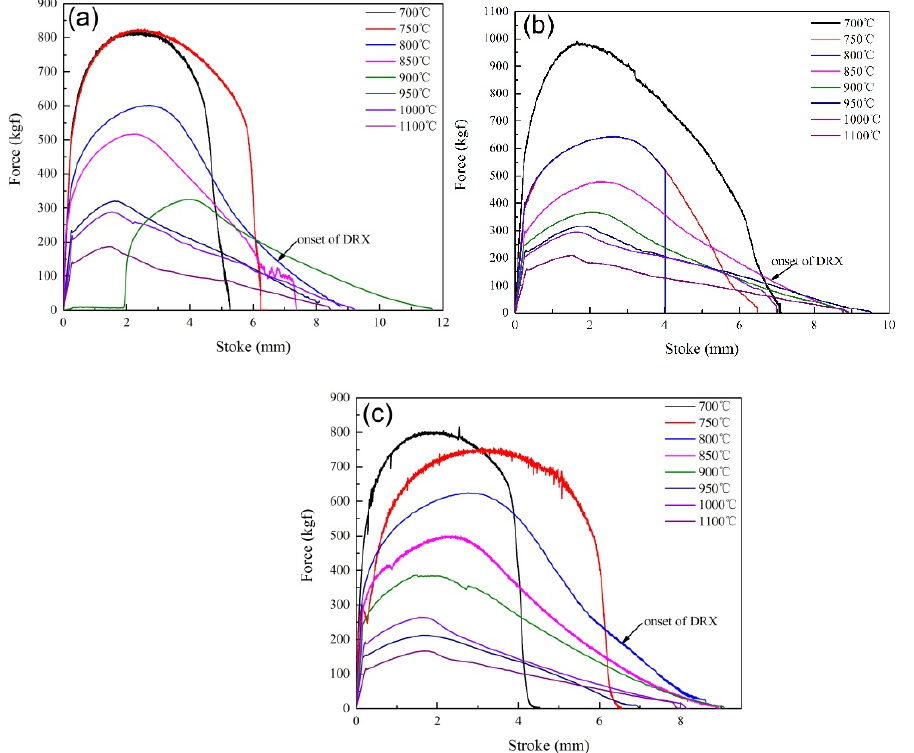
Figure 6. Flow curves of force vs. stroke of different samples tested for ( a ) steel 1; ( b ) steel 2; and ( c ) steel 3.